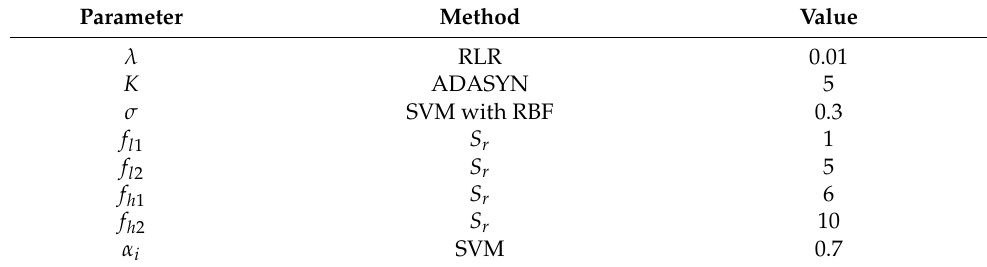
Figure 3. The FFT and STFT results for the seismic signals in Figure 1. Table 1. Numerical parameters for the classification